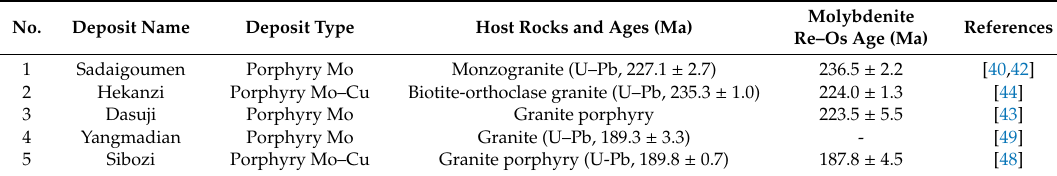
Table 3. Summary of ages of the Mesozoic Mo deposits in the Yan-Liao metallogenic belt, North China